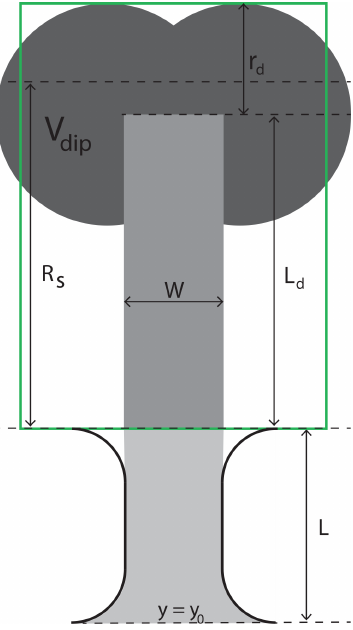
Figure 18. Idealized distribution of a tracer at t = T/ 2 between the dipole (dark gray), jet (medium gray), and strait (light